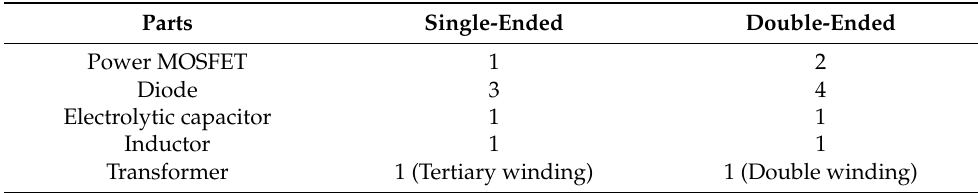
Figure 1. Circuit configuration of two types of forward converters; ( a ) single-ended; ( b ) double-ended. Table 1. Circuit components of two types of forward converters.